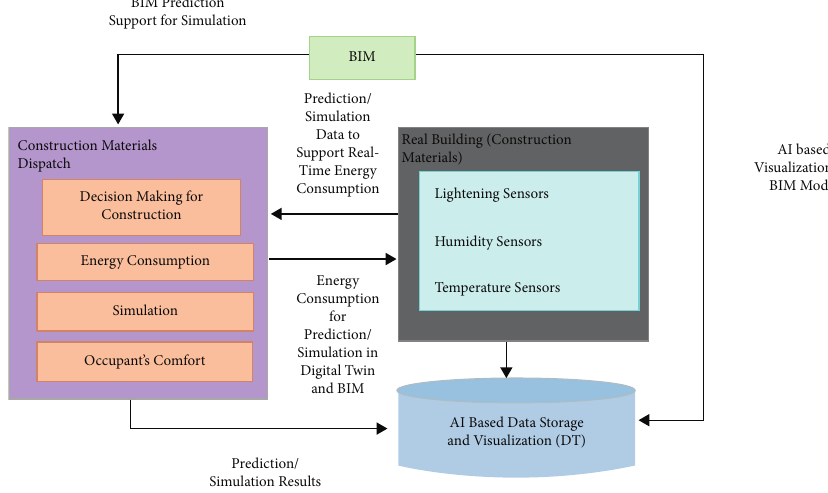
Figure 1: Proposed